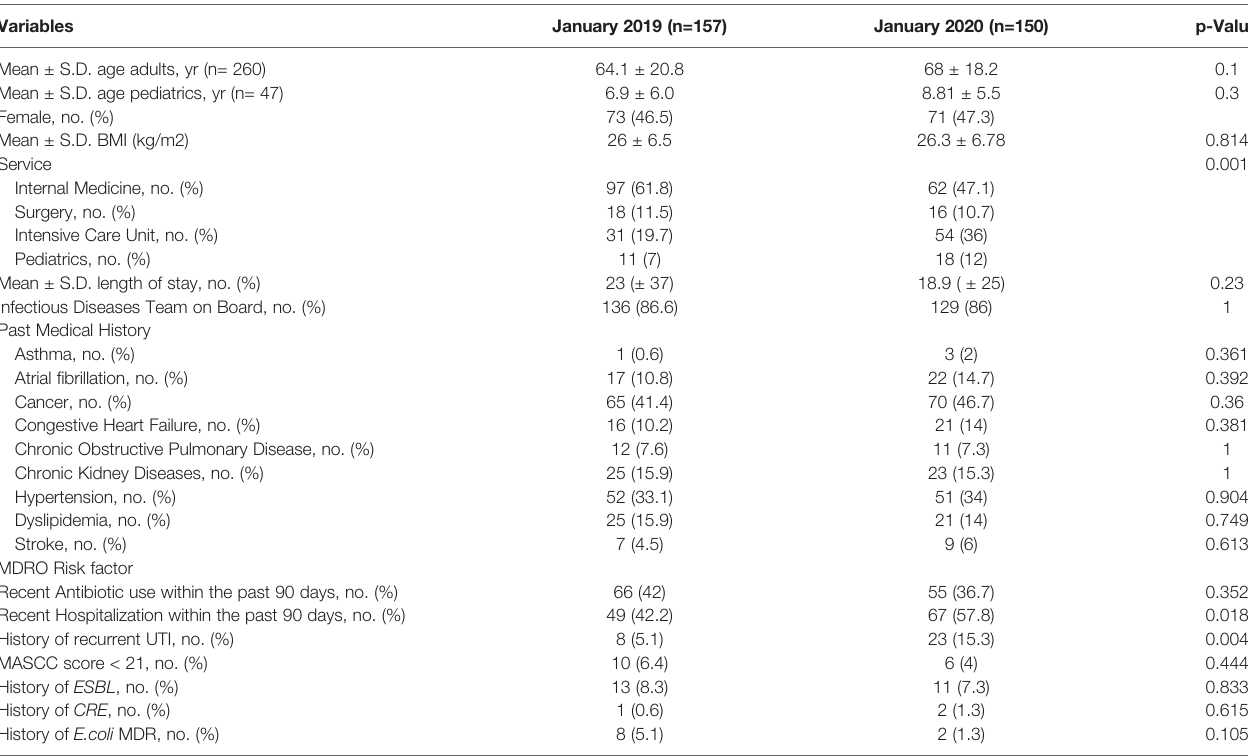
TABLE 1 | Demographic and clinical variables in study